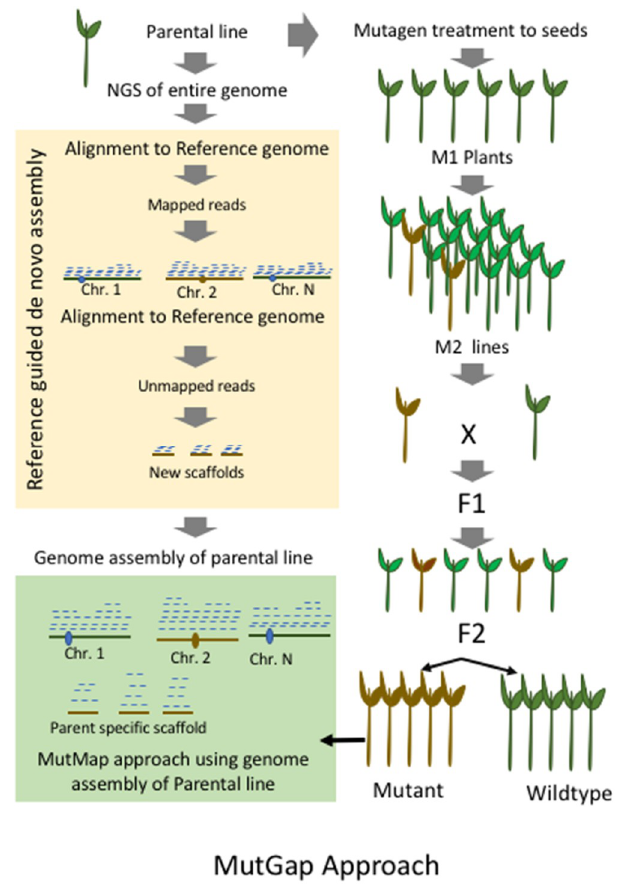
Figure 4. Generalized flowchart of MutMap-Gap approach in which reference parental genome created and gap regions in the parental/cultivar genome identified. Subsequently, MutMap approach needs to be followed as described in Figure